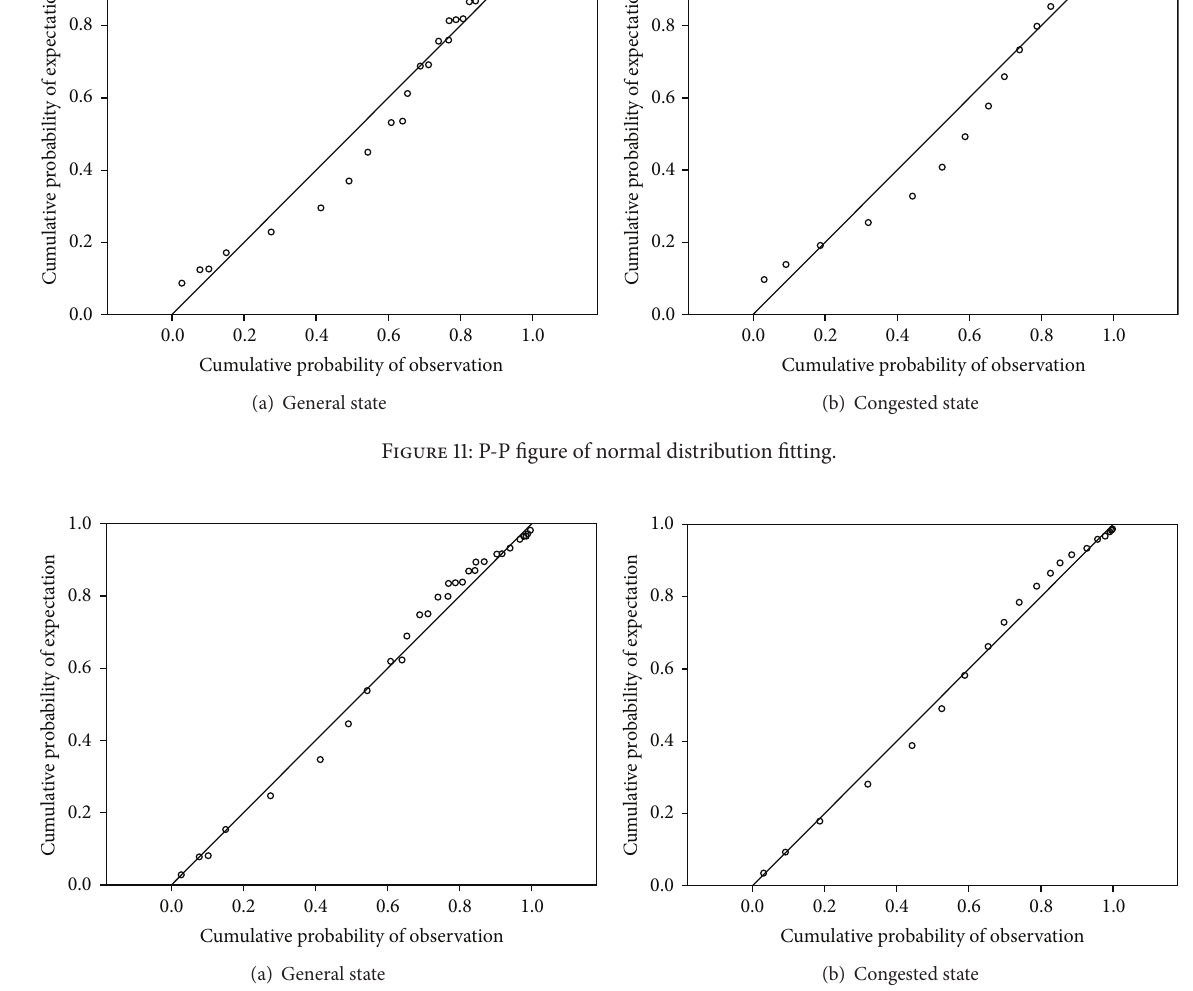
Figure 12: P-P figure of log-normal distribution